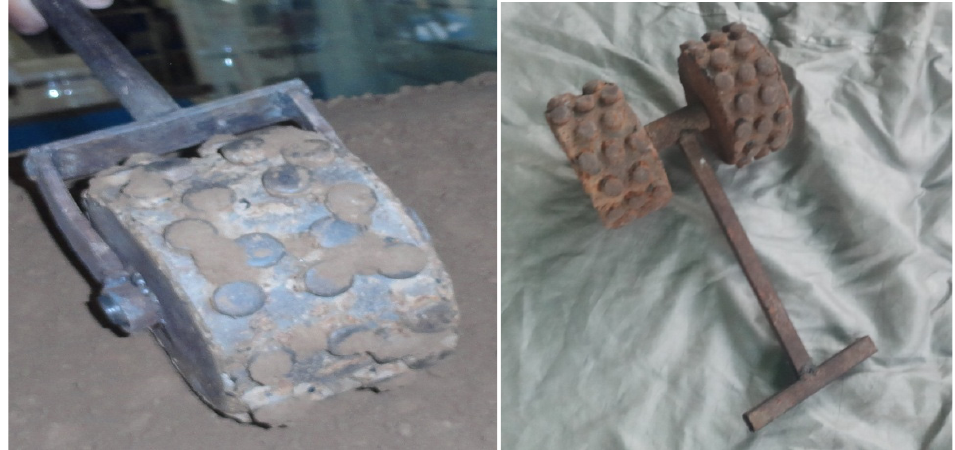
Figure 4. Hand-operated compaction rollers. Table 2. Geometric, geotechnical, and hydraulic characteristics of embankment models.